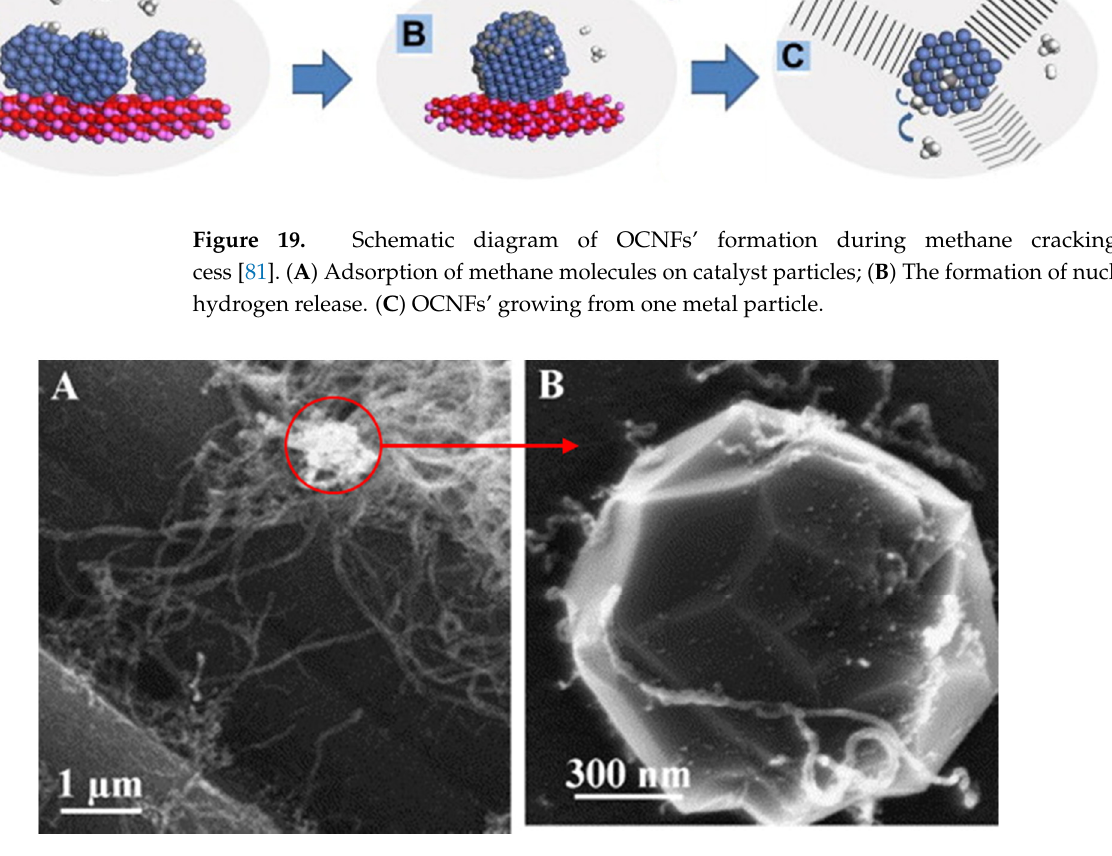
Figure 20. ( A ) Octopus-shaped carbon filaments (OCNFs) deposited on the catalyst. ( B ) The central zoomed catalyst particle observed by SEM [82].